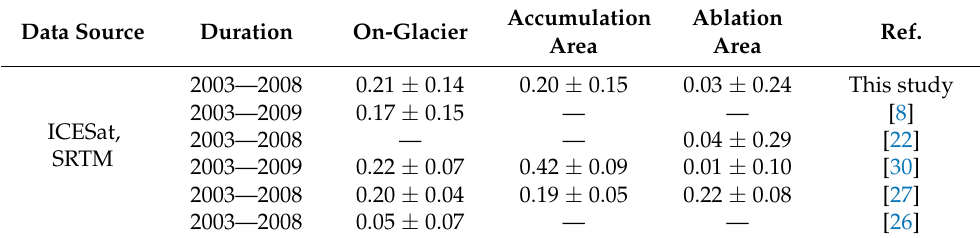
Figure 4. Glacier elevation change trends. ( a ) Accumulation area, ( b ) ablation area, and ( c ) on- glacier area. Table 2. Comparison of glacier elevation change within the WKM region (m/a, ± at 1 σ